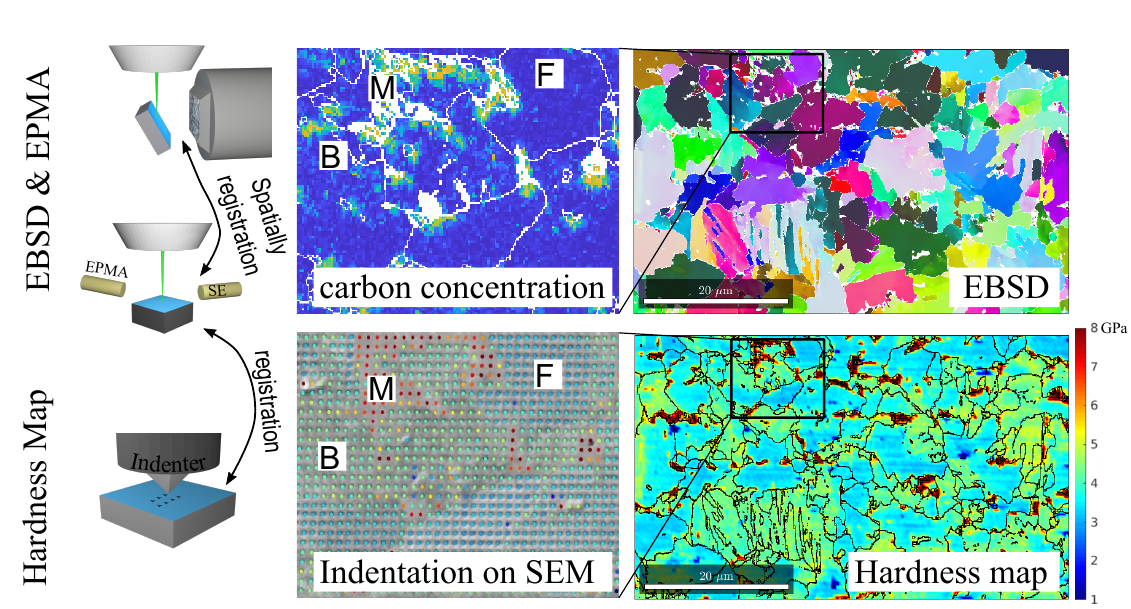
Figure 8. Multifaceted correlative characterization of a complex-phase microstructure (CP800) comprising bainite (B), ferrite (F) and small islands of martensite (M). The hardness map of the microstructure is constructed from around 20,000 nano-indentation points. After spatial registration between various maps, the grain boundaries are overlaid on the hardness map. The carbon concentration map is measured with electron probe microanalyzer (EPMA) where the color code represents the corresponding EPMA signal